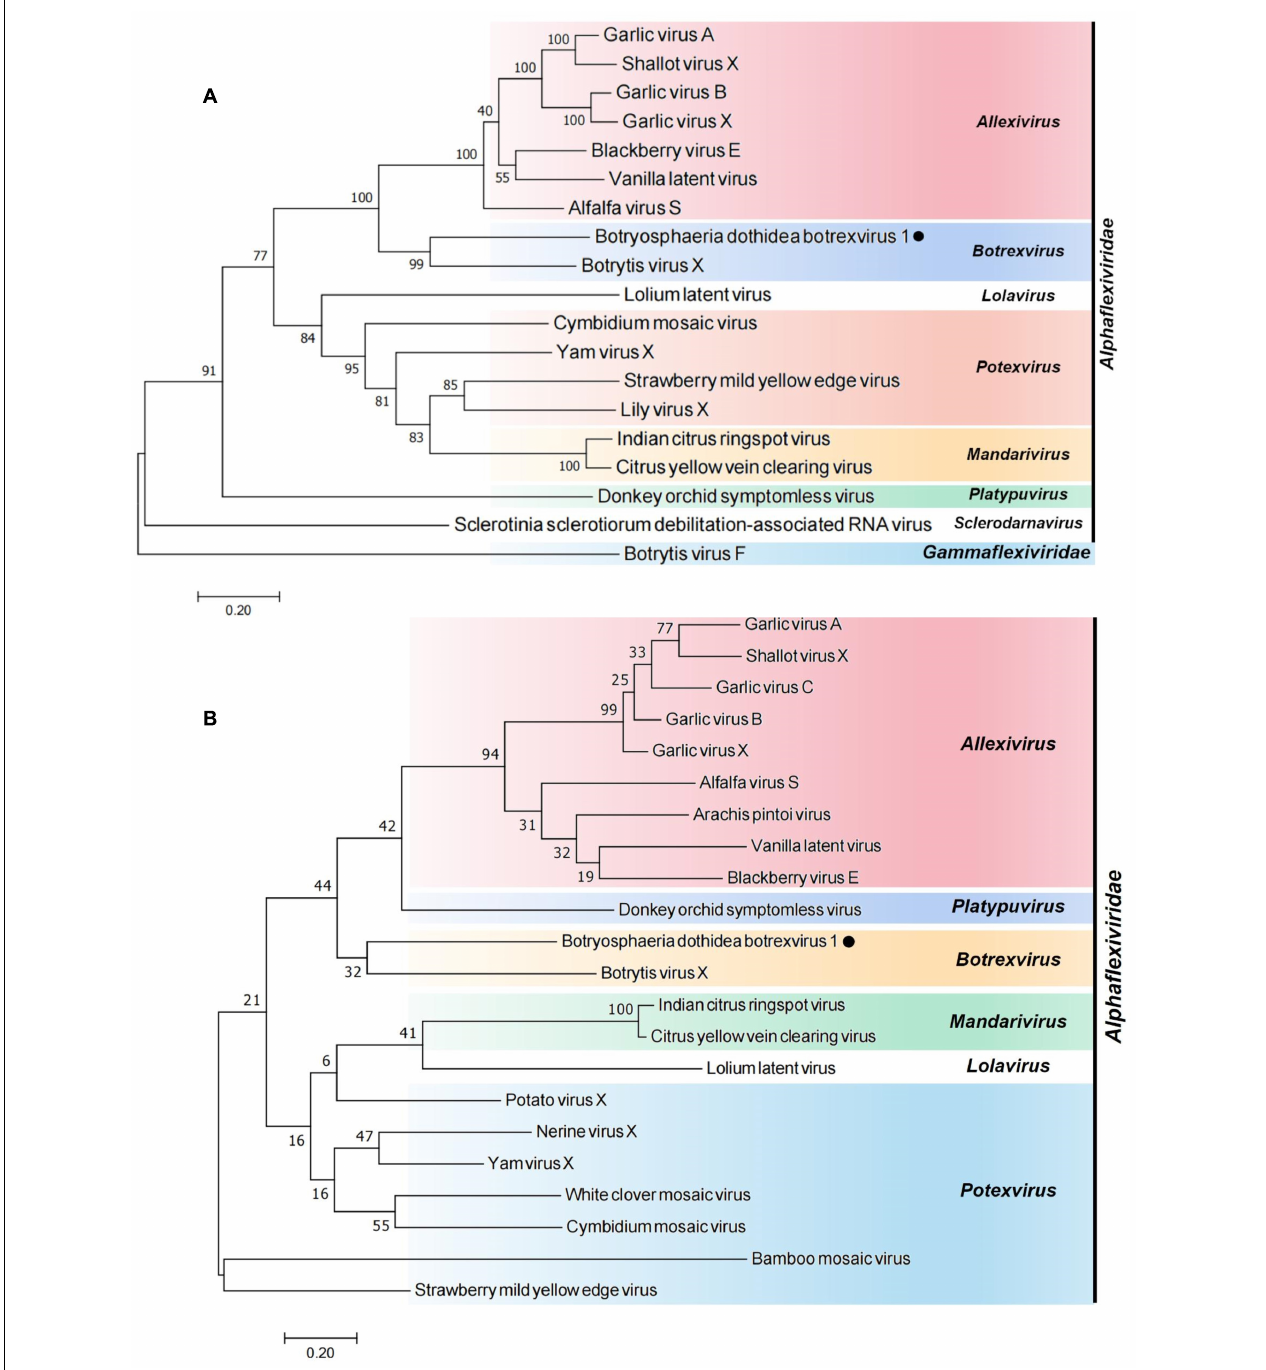
FIGURE 2 | Phylogenetic relationships of BdBV1 with other related viruses. (A) Tree created based on the replicase sequences. (B) Tree created based on the CP sequences. BdBV1 is indicated by a black circle, genera within the Alphaflexiviridae are indicated in different colors.